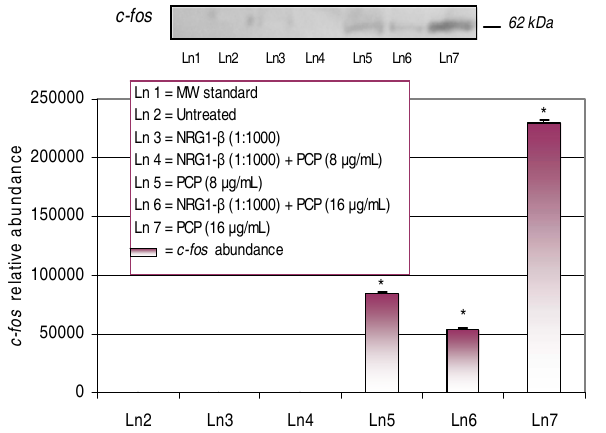
Figure 2: Effect of NRG1- β on PCP toxicity in AML 12 Mouse Hepatocytes. Cells were treated for 48hrs with PCP in the presence or absence of NRG1- β (0.01 nM).